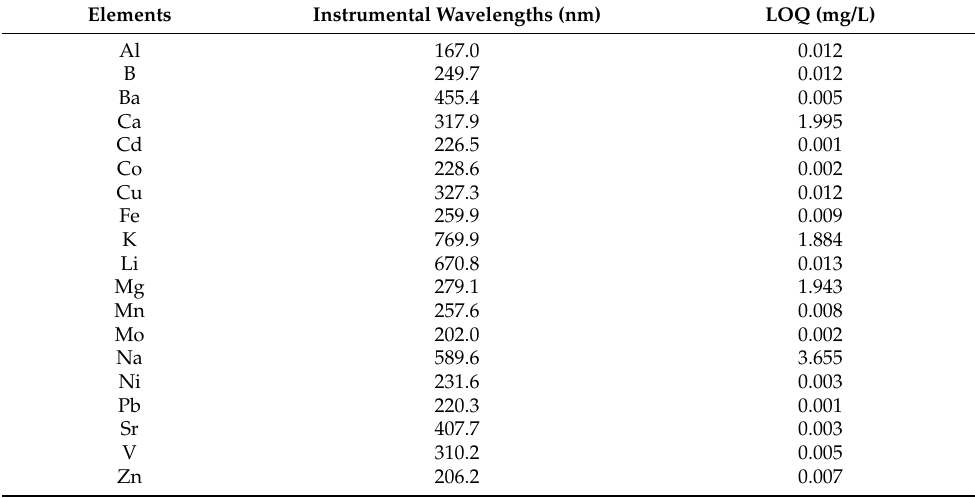
Table 3. Instrumental parameters and quantification limits of the analysis method.